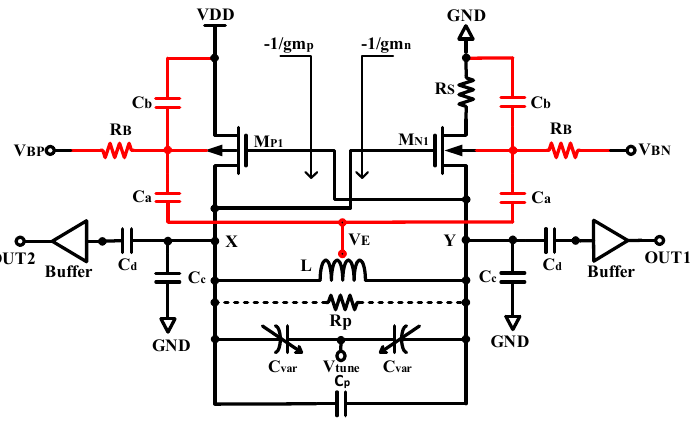
Figure 1. Schematic of the proposed current-reuse voltage-controlled oscillator (VCO). Based on [13], the simplified small signal equivalent circuit is shown in Figure 2.